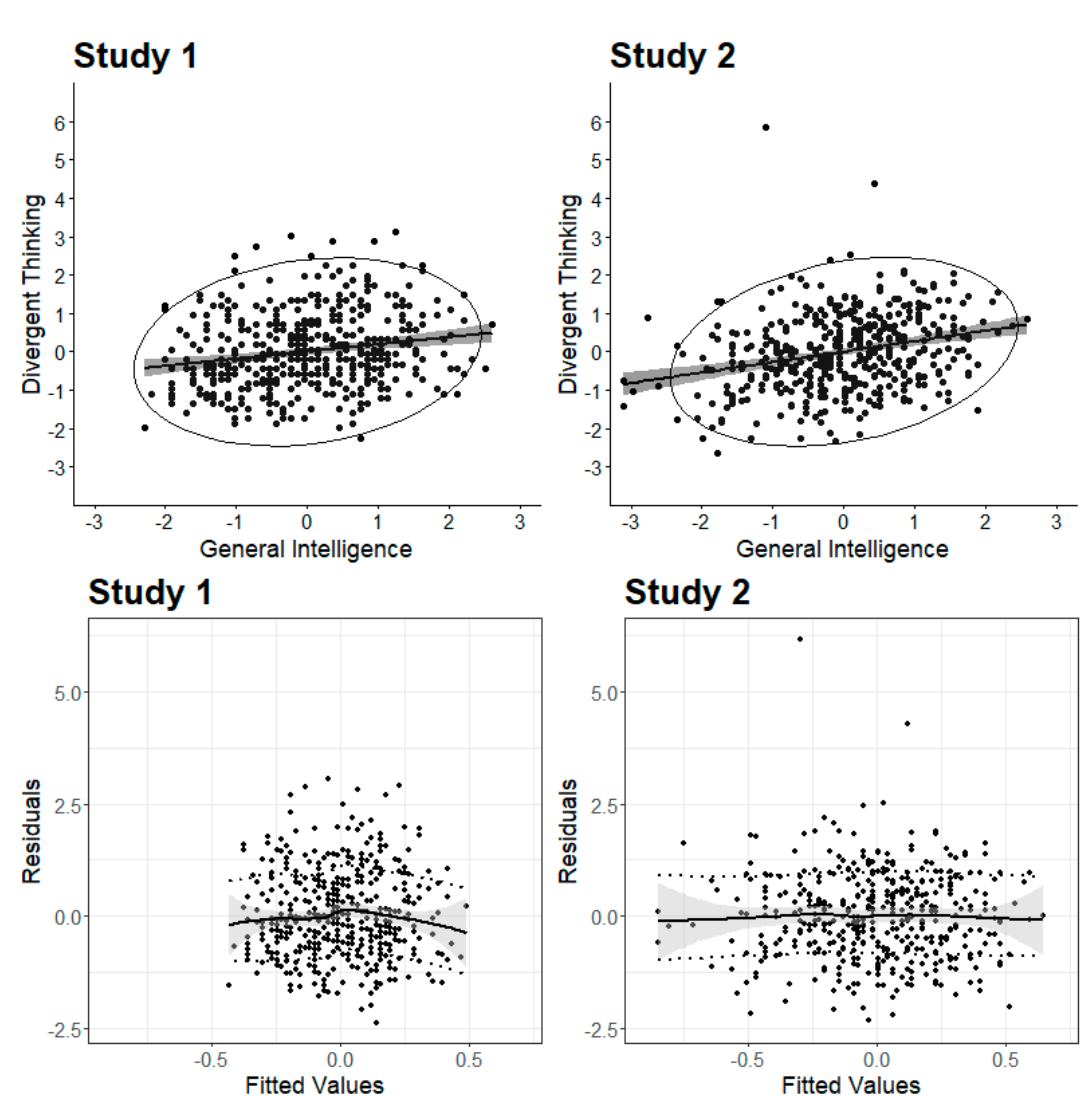
Figure 3. Scatterplots and heteroscedasticity plots. Scatterplots (including the 95% confidence interval) for the correlation between divergent thinking and intelligence are presented upper part. Heteroscedasticity plots including standard errors (grey) and standard deviations of the fitted values (dashed line) are given in the lower part.